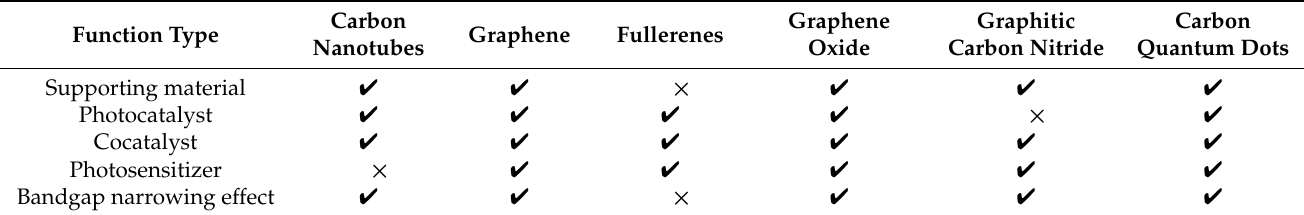
Table 2. Role of carbon nanomaterials in